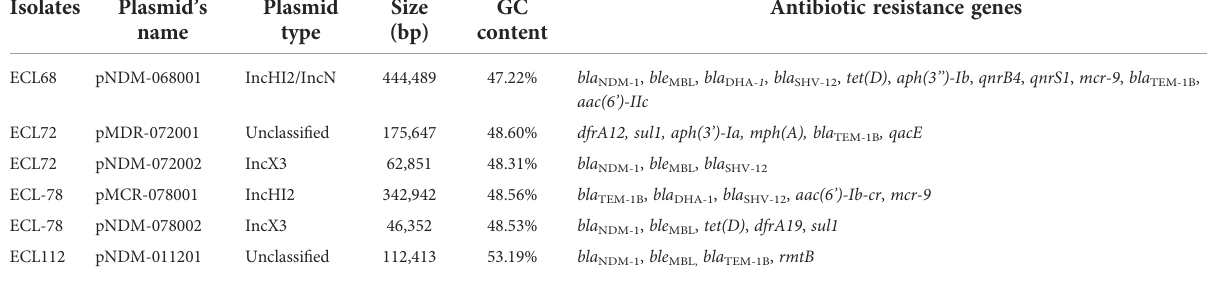
TABLE 3 The major features of plasmids.